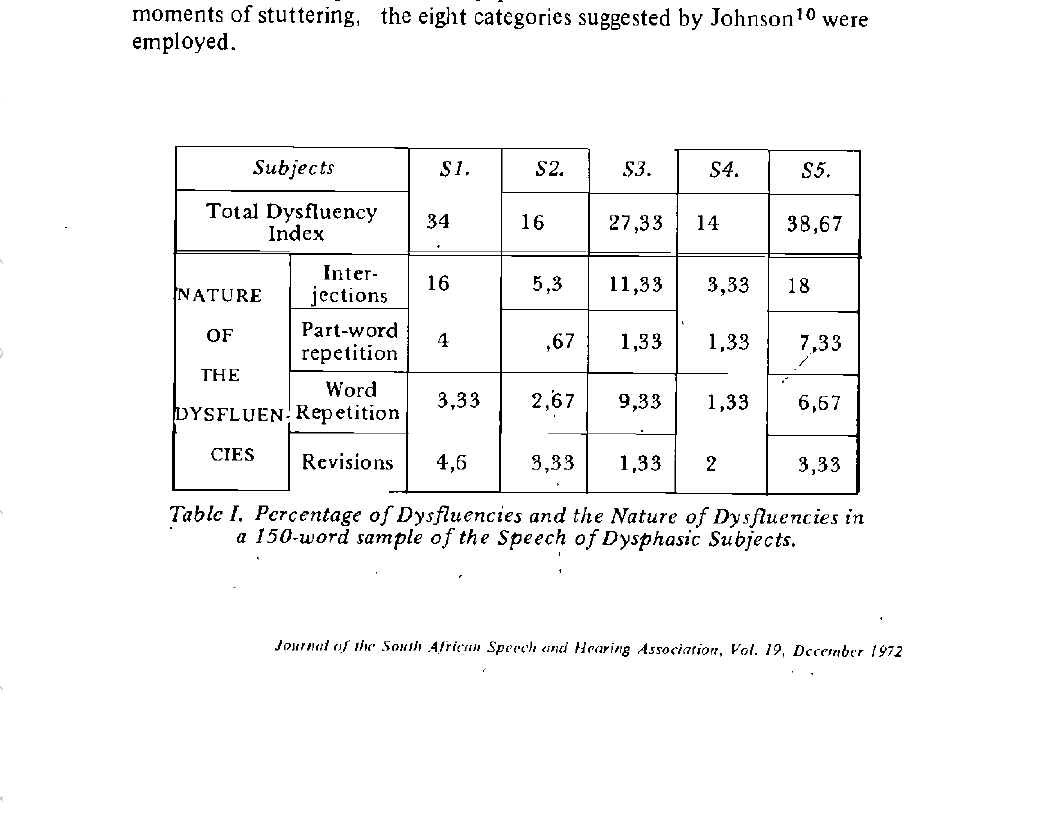
Table I. Percentage of Dysfluencies and the Nature of Dysfluencies in a 150-word sample of the Speech of Dysphasic